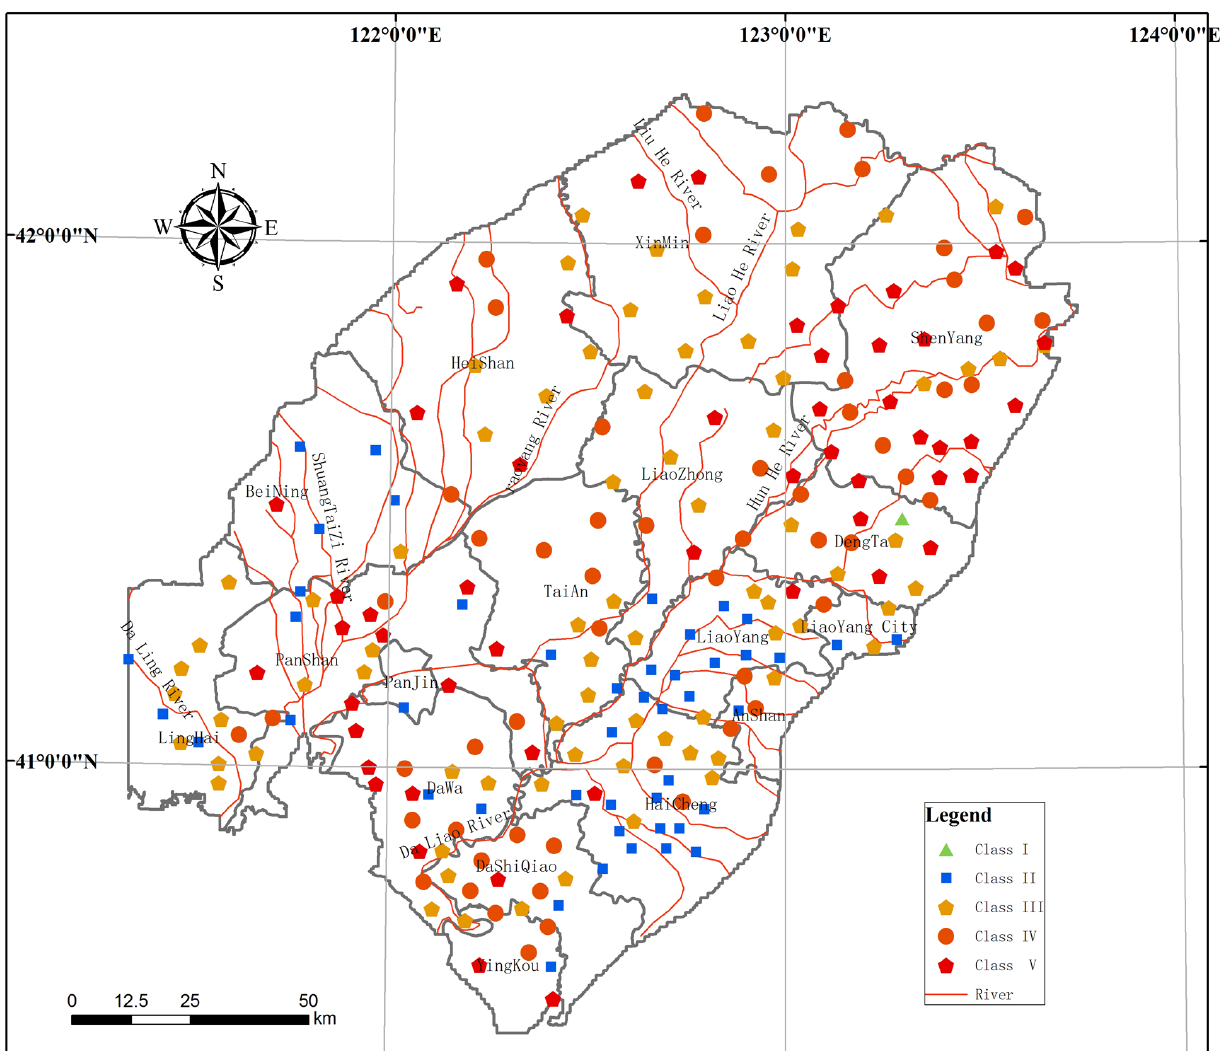
Fig 8. Comprehensive evaluation of groundwater quality in the study